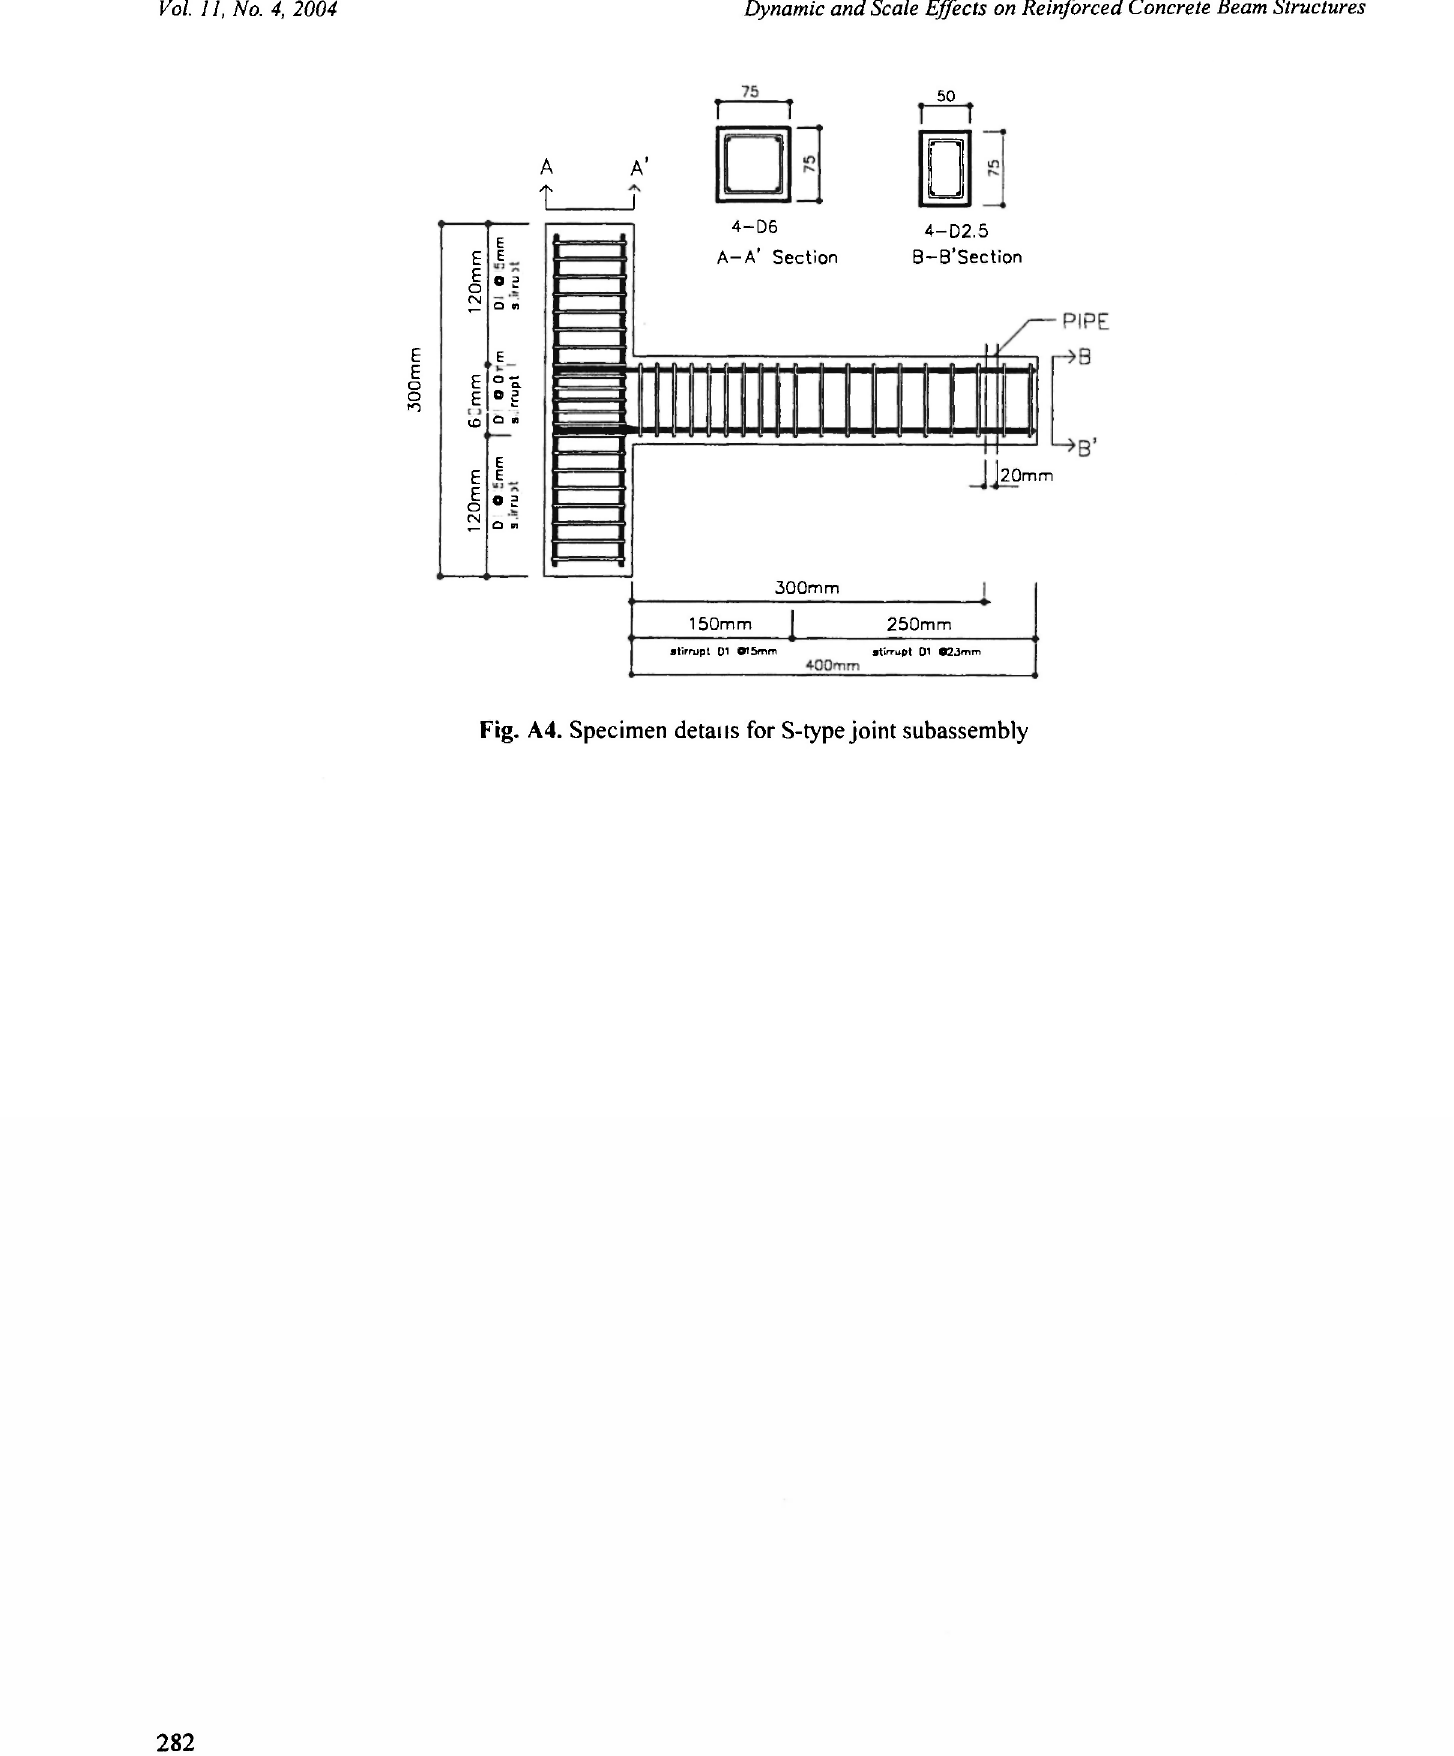
Fig. A4. Specimen details for S-type joint